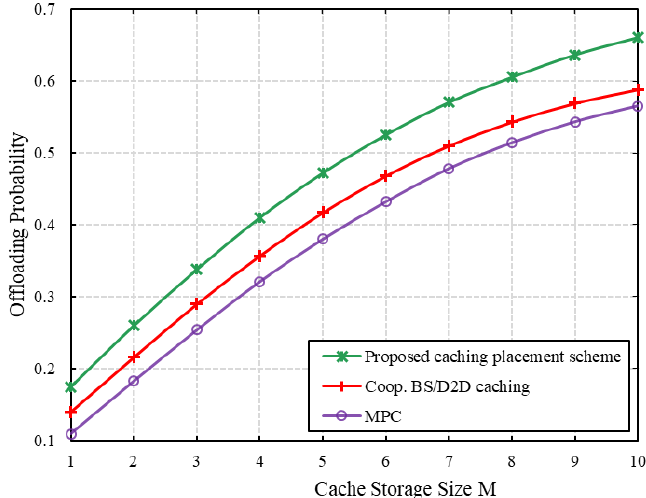
Figure 5. Performance comparison among three different caching schemes versus the cache storage size M .